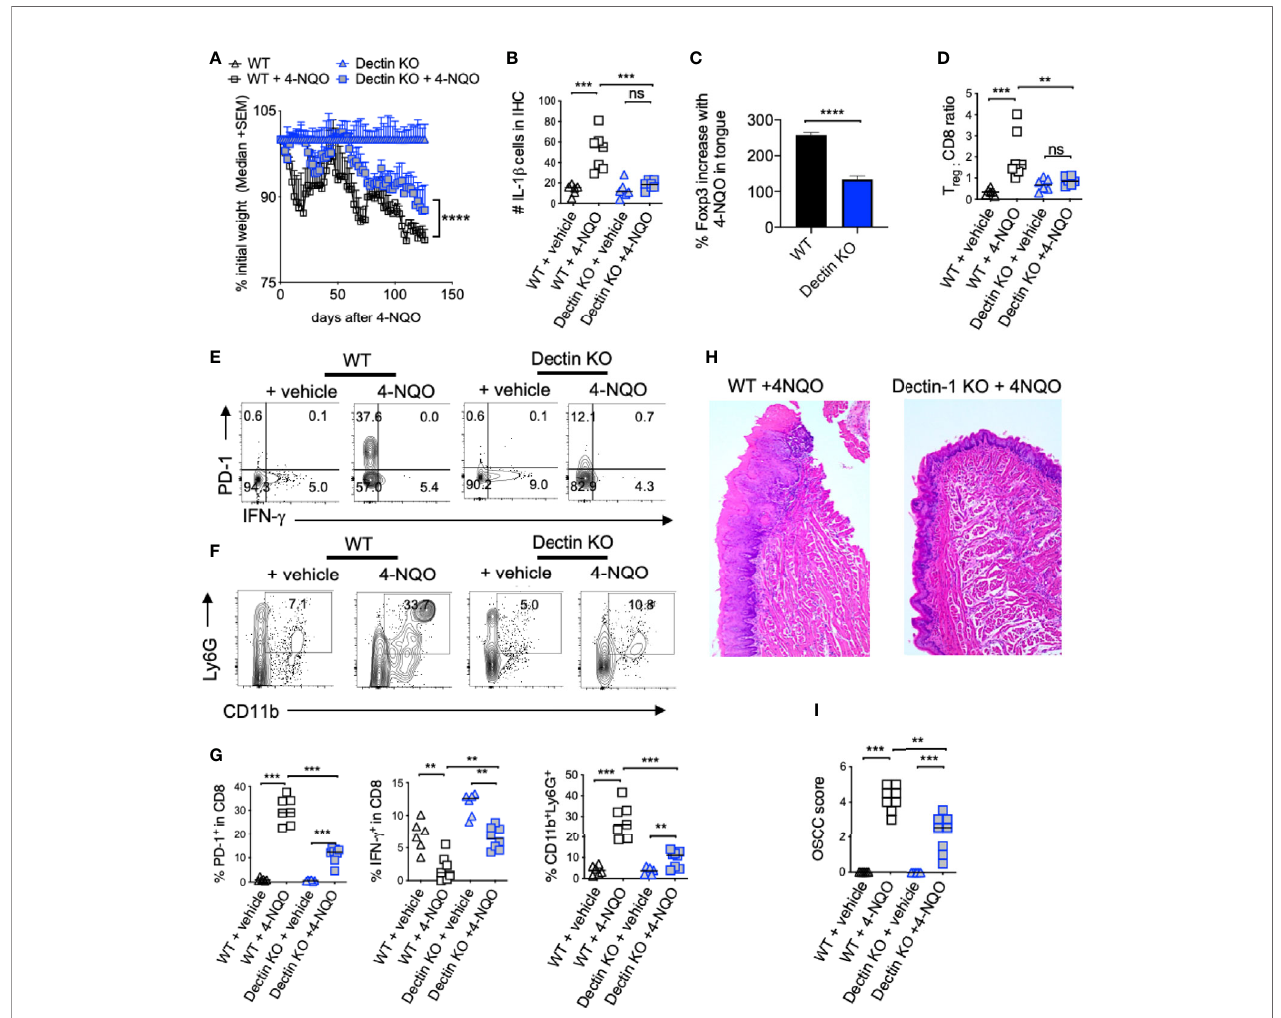
FIGURE 7 | Dectin-1 de fi ciency reduces immunosuppressive cells and OSCC tumor burden. Statistics showing the body weight loss, comparing the indicated groups (A) . Tongue tissues were processed for immunohistochemistry (IHC) and fl ow cytometry at 23 weeks after 4-NQO administration. Statistics showing the number of IL-1 b + cells in the entire fi eld of 200X IHC image (B) . Flow cytometry-based statistics showing % increase in T regs in 4-NQO treated mice compared to Veh. controls (C) , T reg :CD8 ratio (D) , the % of PD-1 and IFN- g expressing CD8 cells (E) , the % of CD11b and Ly6G expressing CD45 + cells (F) , and the statistical analysis for all of the above (G) . H&E immunohistochemistry of tongue (H) , and blinded OSCC scoring (I) . (Mann-Whitney test except for (B) , where t-test